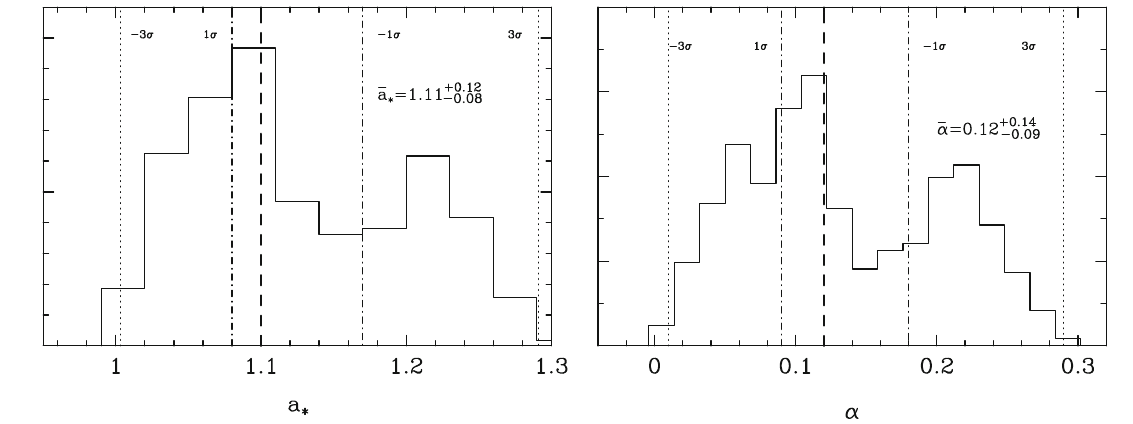
Fig. 8 Histograms of the spin parameter a ∗ (left panel) and of the deformation parameter α (right panel) for Swift J0501.9–3239 from our MCMC analysis. The thick-dashed vertical lines mark the mean value